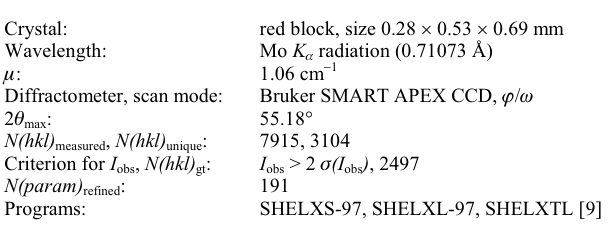
Table 1. Data collection and handling.